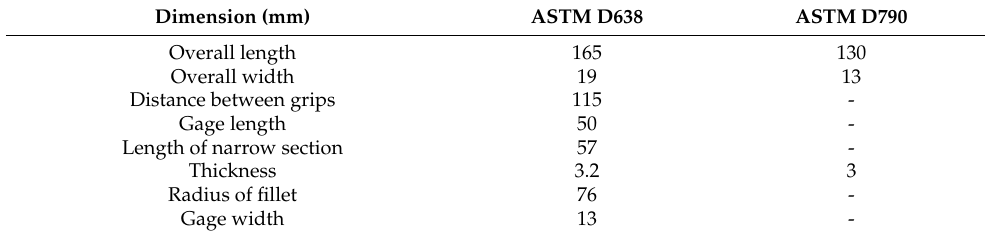
Table 3. Dimension of ASTM D638 and ASTM D790 standard